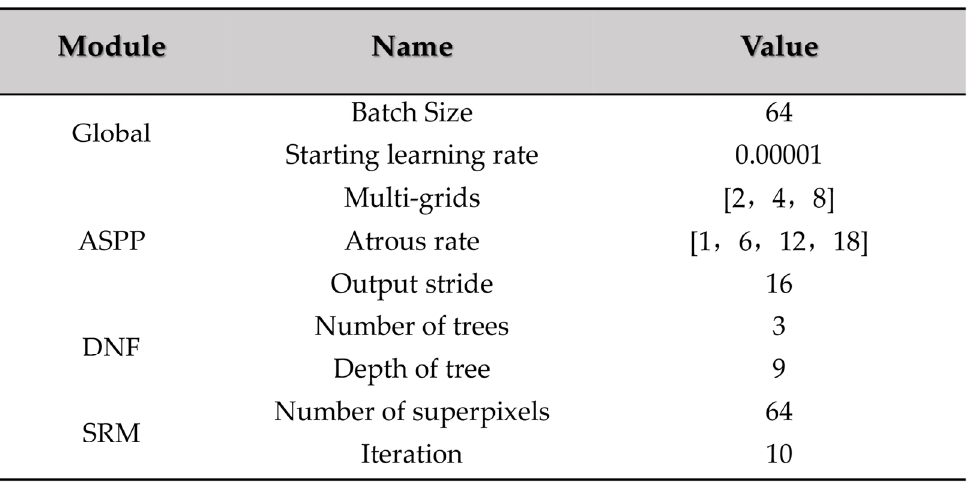
Figure 7. Model parameters.